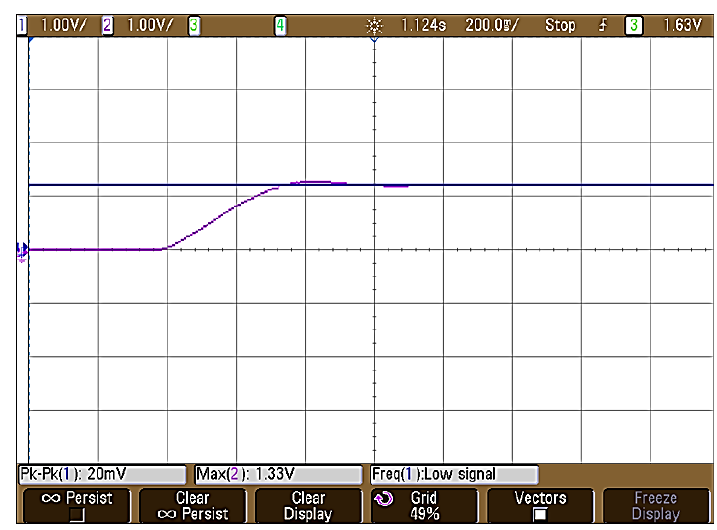
Figure 20. Voltage source inverter-fed BLDC motor output current waveform.